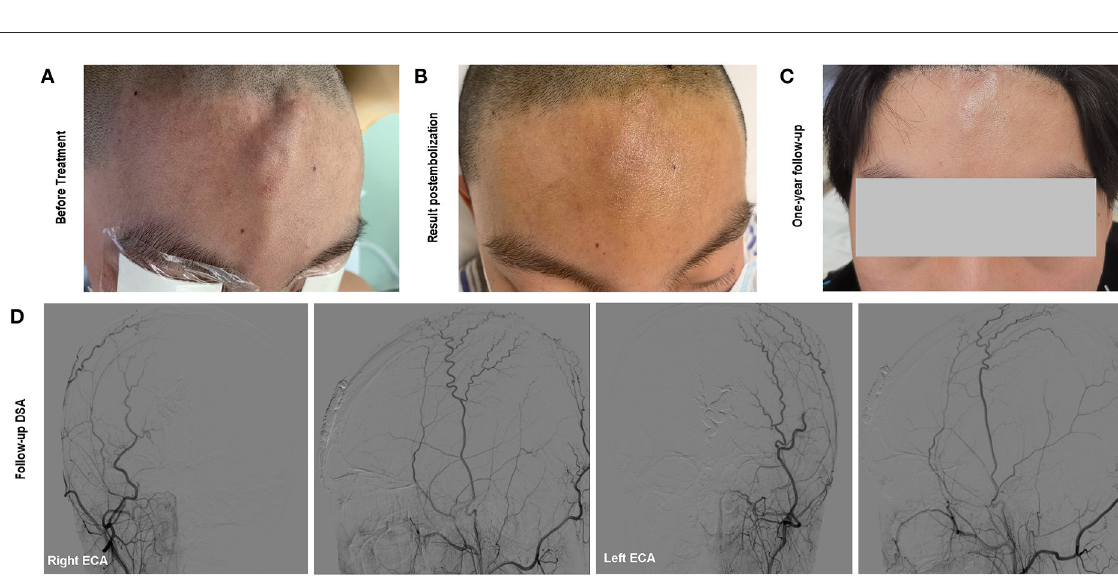
FIGURE3 (A) The soft and pulsatile lesion with no clear border before treatment; (B) Immediate status of the lesion postembolization; (C) One-year follow-up showed no evidence of recurrence and scalp necrosis. Onyx was not visible beneath the skin; (D) Follow-up angiography showed complete occlusion of the scalp